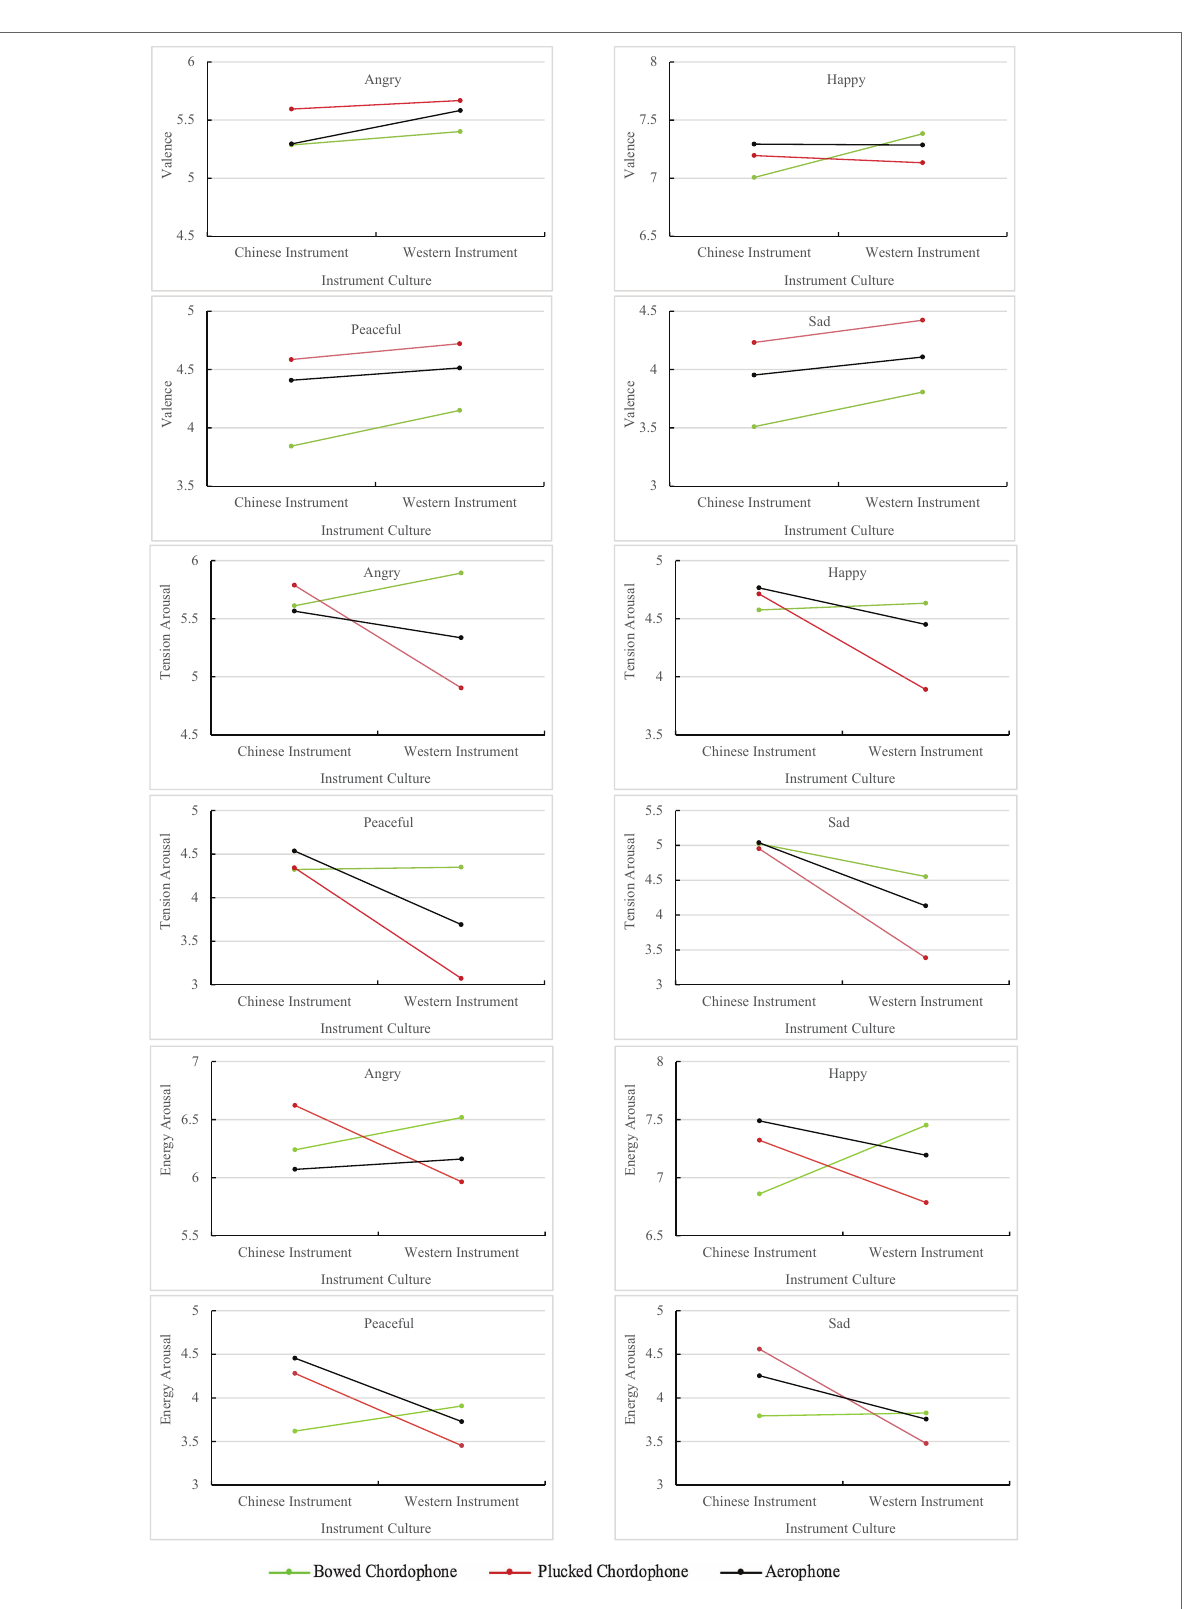
FIGURE 3 | Plots of the three-way interactions between instrument category, instrument culture, and musical emotion for the three perceived affect